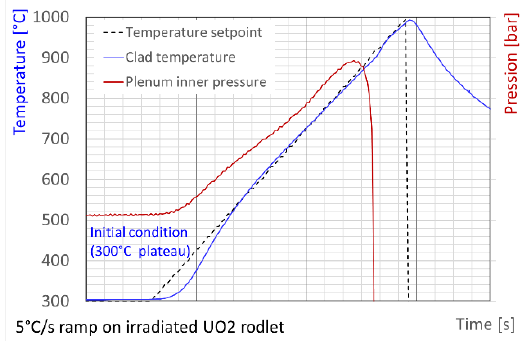
Fig. 7. Clad temperature and rod inner pressure recordings during the first test on irradiated UO 2 .